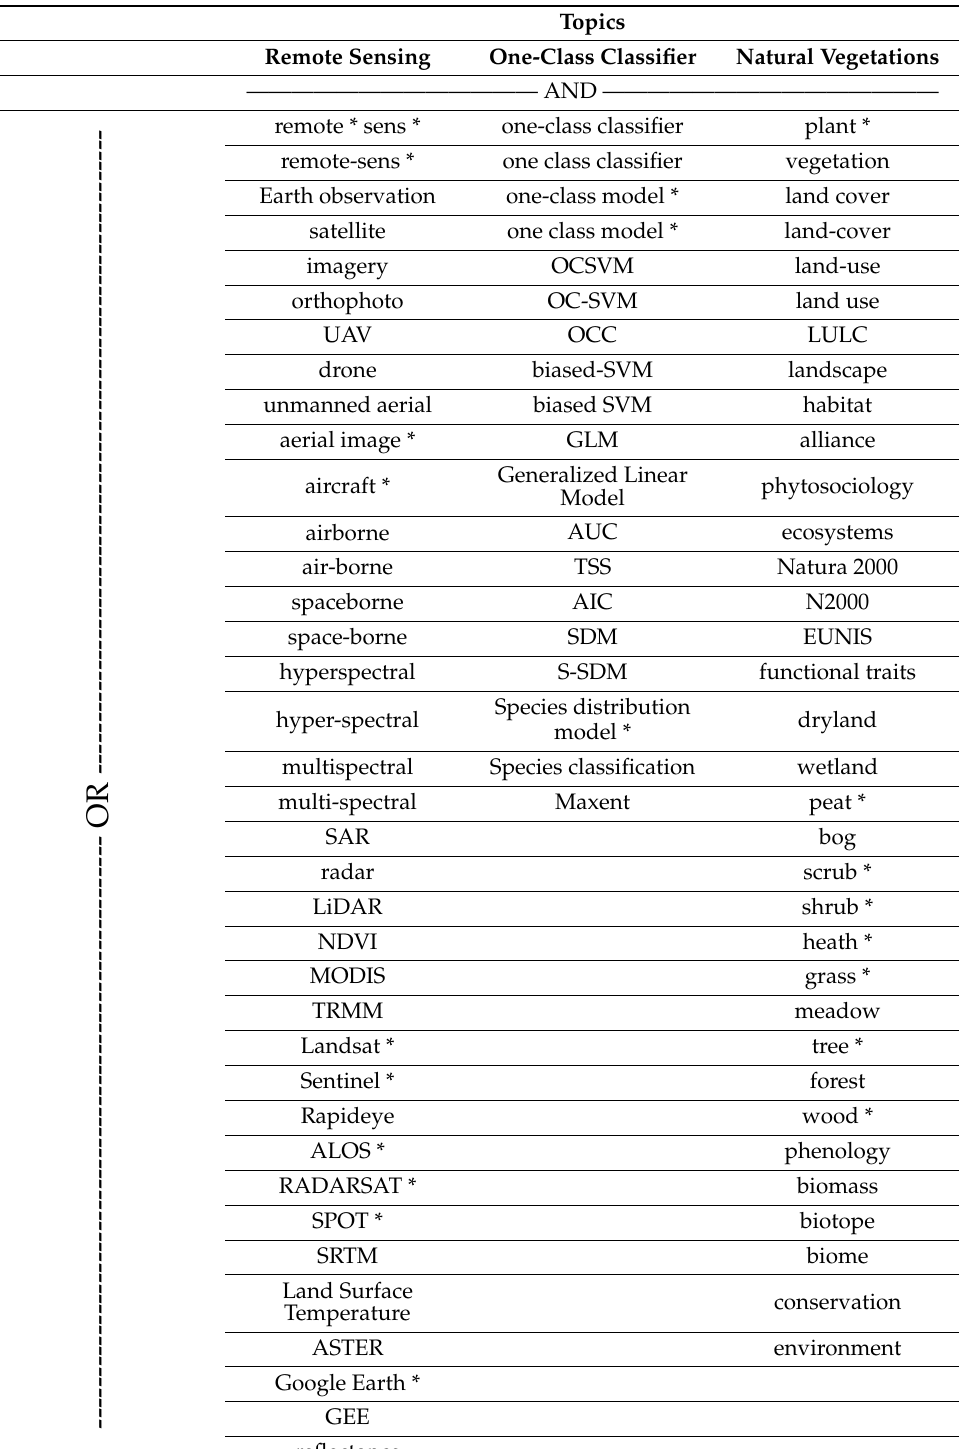
Table 1. Keywords selected per topics for the literature searching. The asterisk (*) was used to retrieve variations of a term.